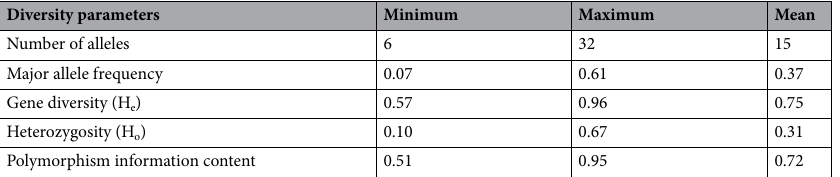
Table 1. Range and mean values for allelic composition, gene diversity, heterozygosity and polymorphism information content (PIC) of 29 simple sequence repeat (SSR) loci in 45 pearl millet